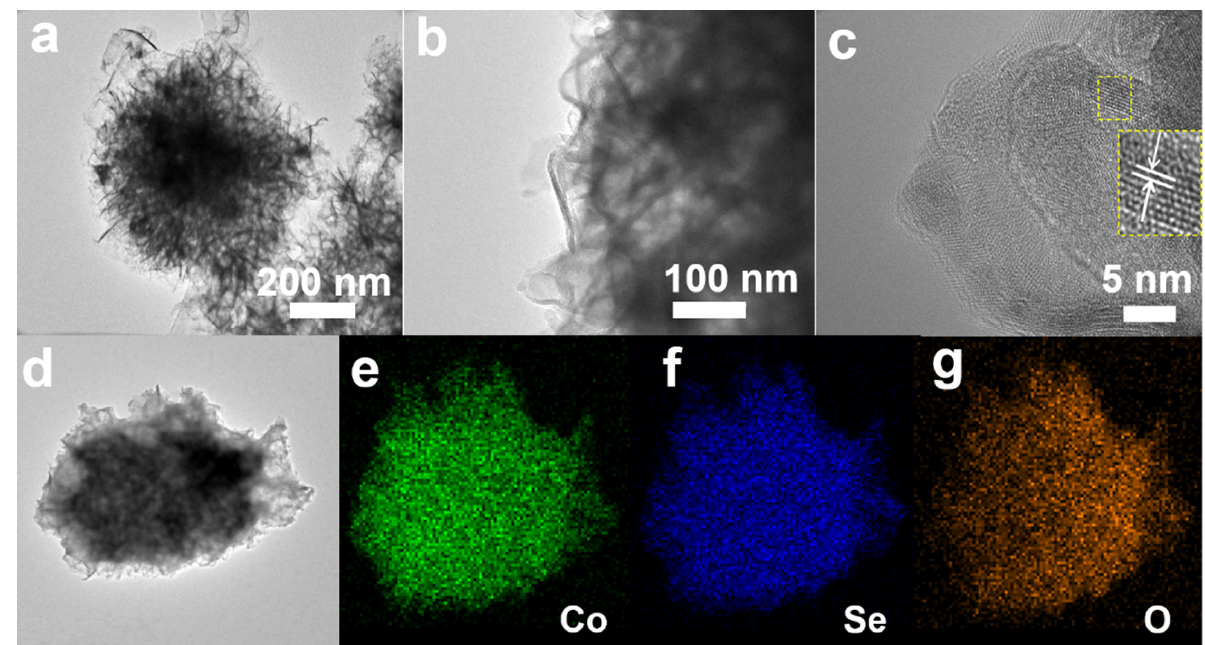
Figure 2. ( a,b ) TEM images, ( c ) HRTEM image, and ( d ) STEM image of the CoSeO 3 ‧ 2H 2 O nanoflow- Figure 2. ( a , b ) TEM images, ( c ) HRTEM image, and ( d ) STEM image of the CoSeO 3 · 2H 2 O nanoflow- ers; ( e–g ) EDX mapping images of Co, Se, and O. ers; ( e – g ) EDX mapping images of Co, Se, and